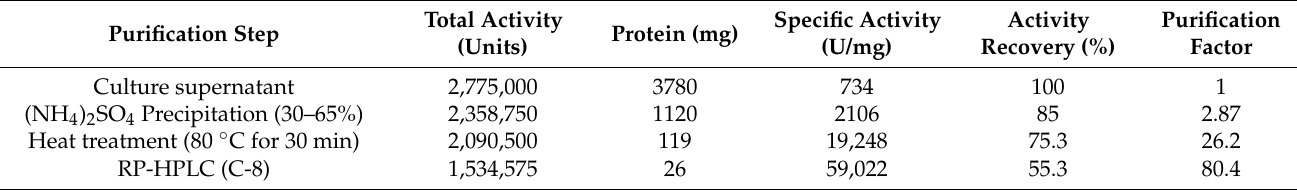
Table 1. Flow sheet for Ba.St.Pr purification (300 mL